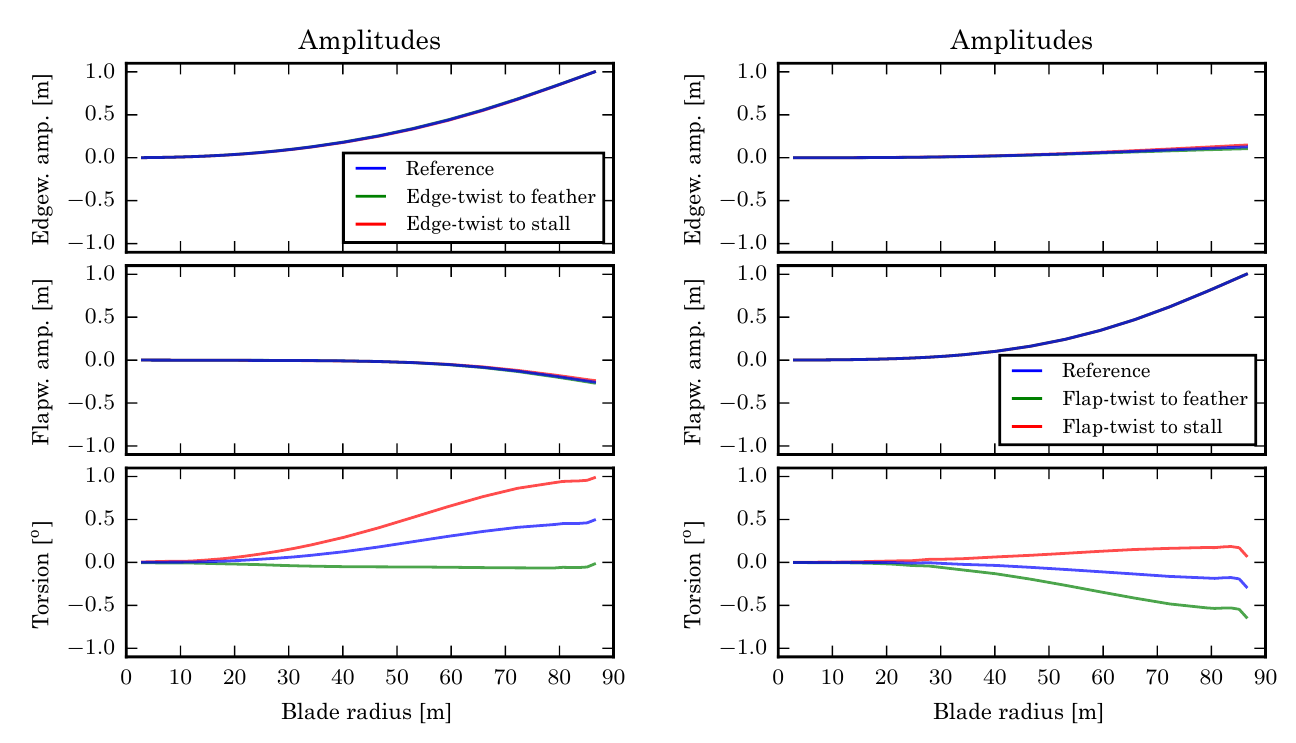
Figure 5. Structural mode shape of the first edgewise mode for the reference blade, and edge–twist coupled blades with constant cou- pling coefficients of γ x = ± 0 . 1. Positive coupling coefficients de- note twist to stall for edgewise deflection towards the leading edge. The amplitudes are normalized to 1m tip deflection in the edgewise direction.